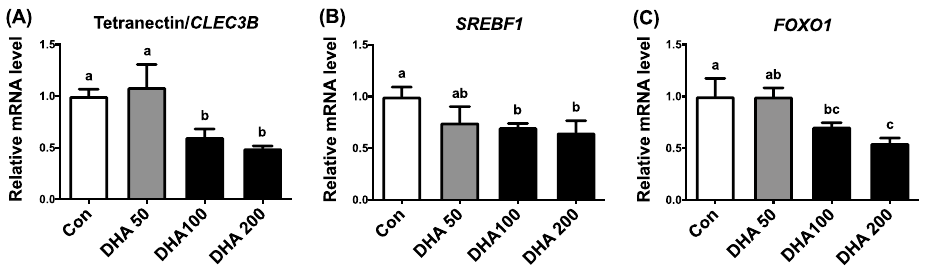
Figure 7. Effects of DHA on expression of TN, SREBP-1c and FoxO1 in human HEK293T cells. Expression of ( A ) tetranectin (TN/ CLEC3B ), ( B ) sterol regulatory element-binding protein 1c (SREBP-1c/ SREBF1 ) and ( C ) forkhead box O1 (FoxO1) was determined by qPCR in human HEK293T cells. HEK293T cells were cultured and supplemented with various concentrations (0 = Con, 50, 100, 200 μM) of docosahexaenoic acids (DHA) for 24 h ( n = 3). Data were expressed as mean ± SD and normalized to β-actin expression in the same sample. Data were analyzed by ANOVA. Different superscript letters (a, b, c) indicate significant difference ( p ≤ 0.05) determined by Tukey’s multiple comparison test.